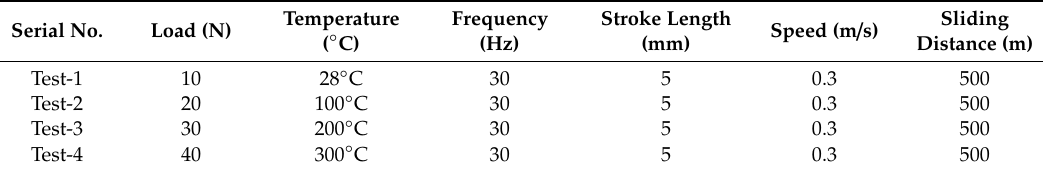
Table 1. Parameters used in tribological